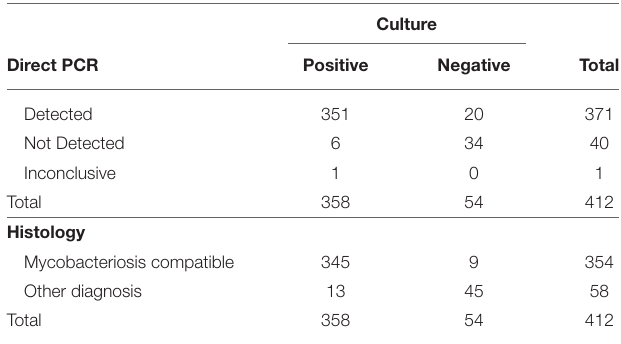
TABLE 2 | Distribution of culture, histology and direct PCR results for the detection of M. bovis from tissue from dairy cattle from Baja California, Mexico.